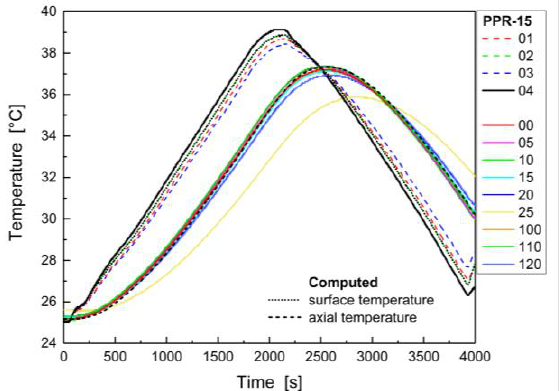
Figure 20. Time-history of measured temperatures and computed surface and axial temperatures (measurement B — temperature increase in climate chamber by 15 °C/probe 1).